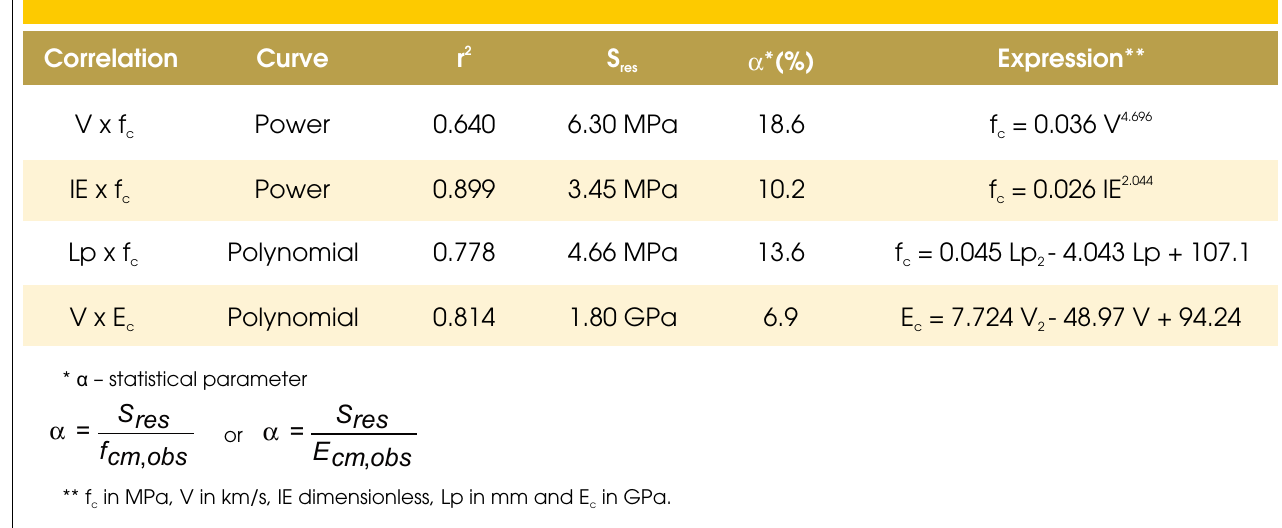
Table 3 – Proposed expressions to correlate f with V, f with IE, f with Lp and E with V.